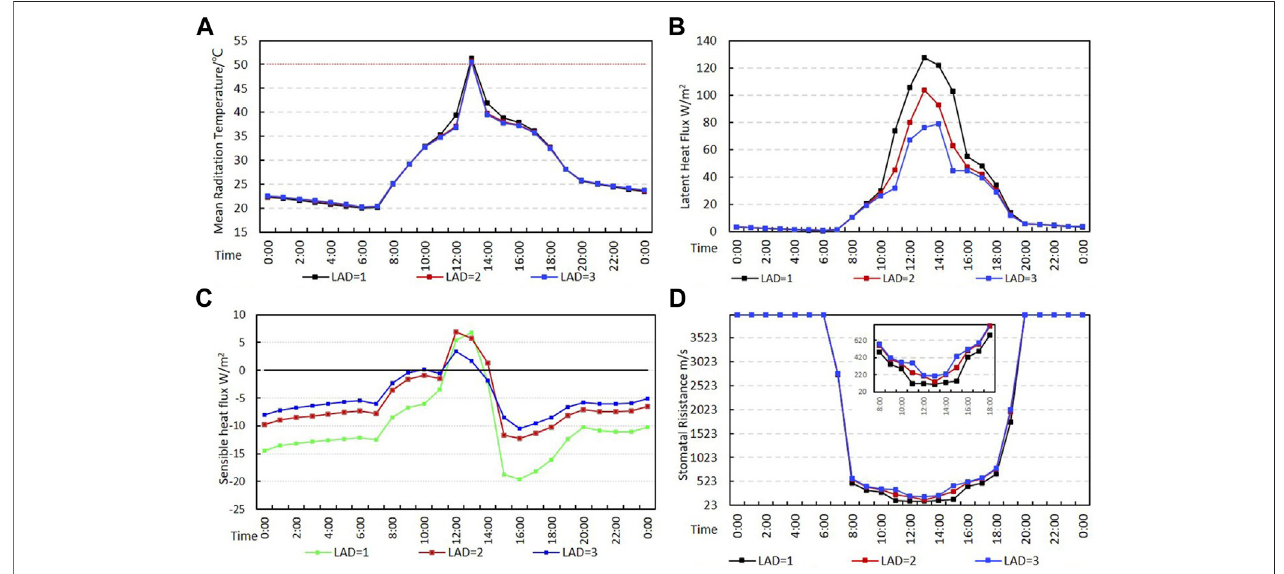
FIGURE 10 | Pro fi les of meteorological parameters in canyons with different LAD-mean radiation temperature (A) , latent heat fl ux (B) , sensible heat fl ux (C) and stomatal risistance (D) .